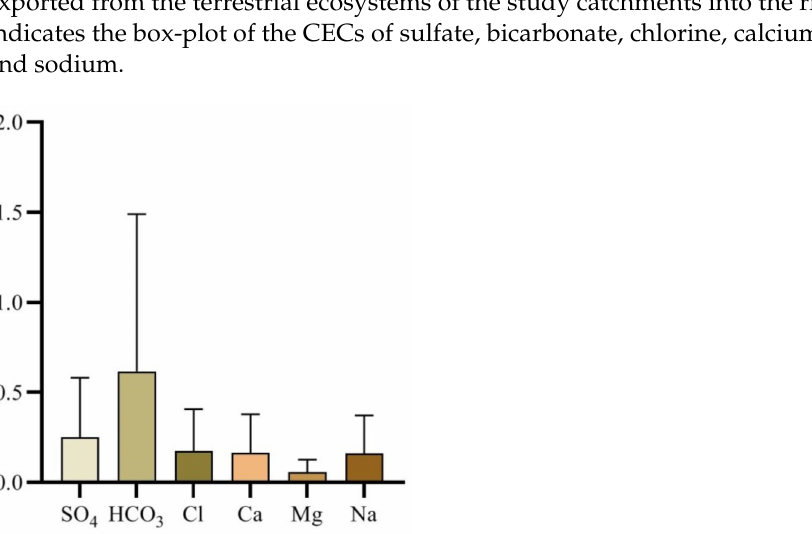
Figure 3. Box-plot of the CECs of water quality parameters for the study catchments.